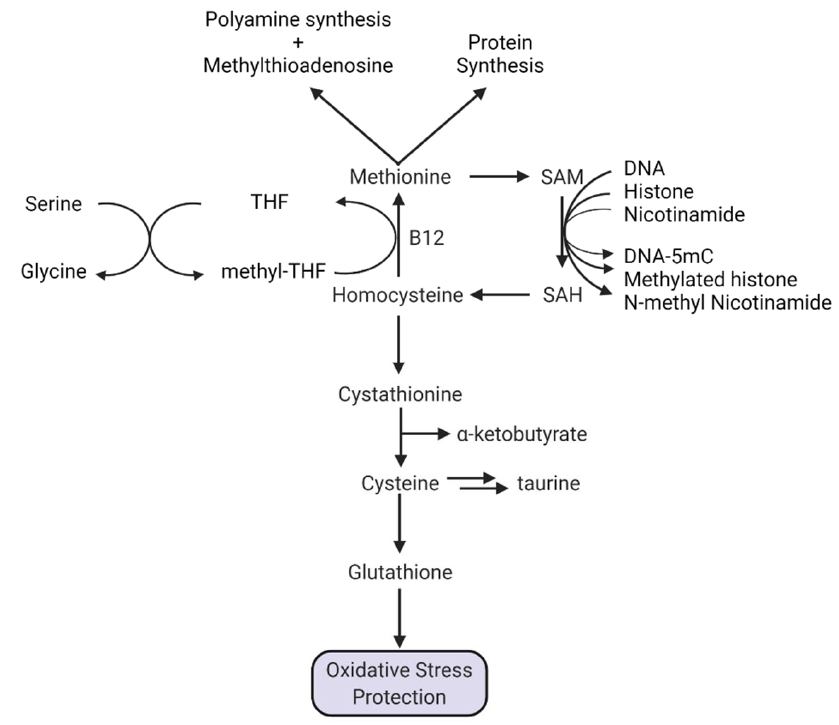
Figure 1. Methionine metabolic pathways.